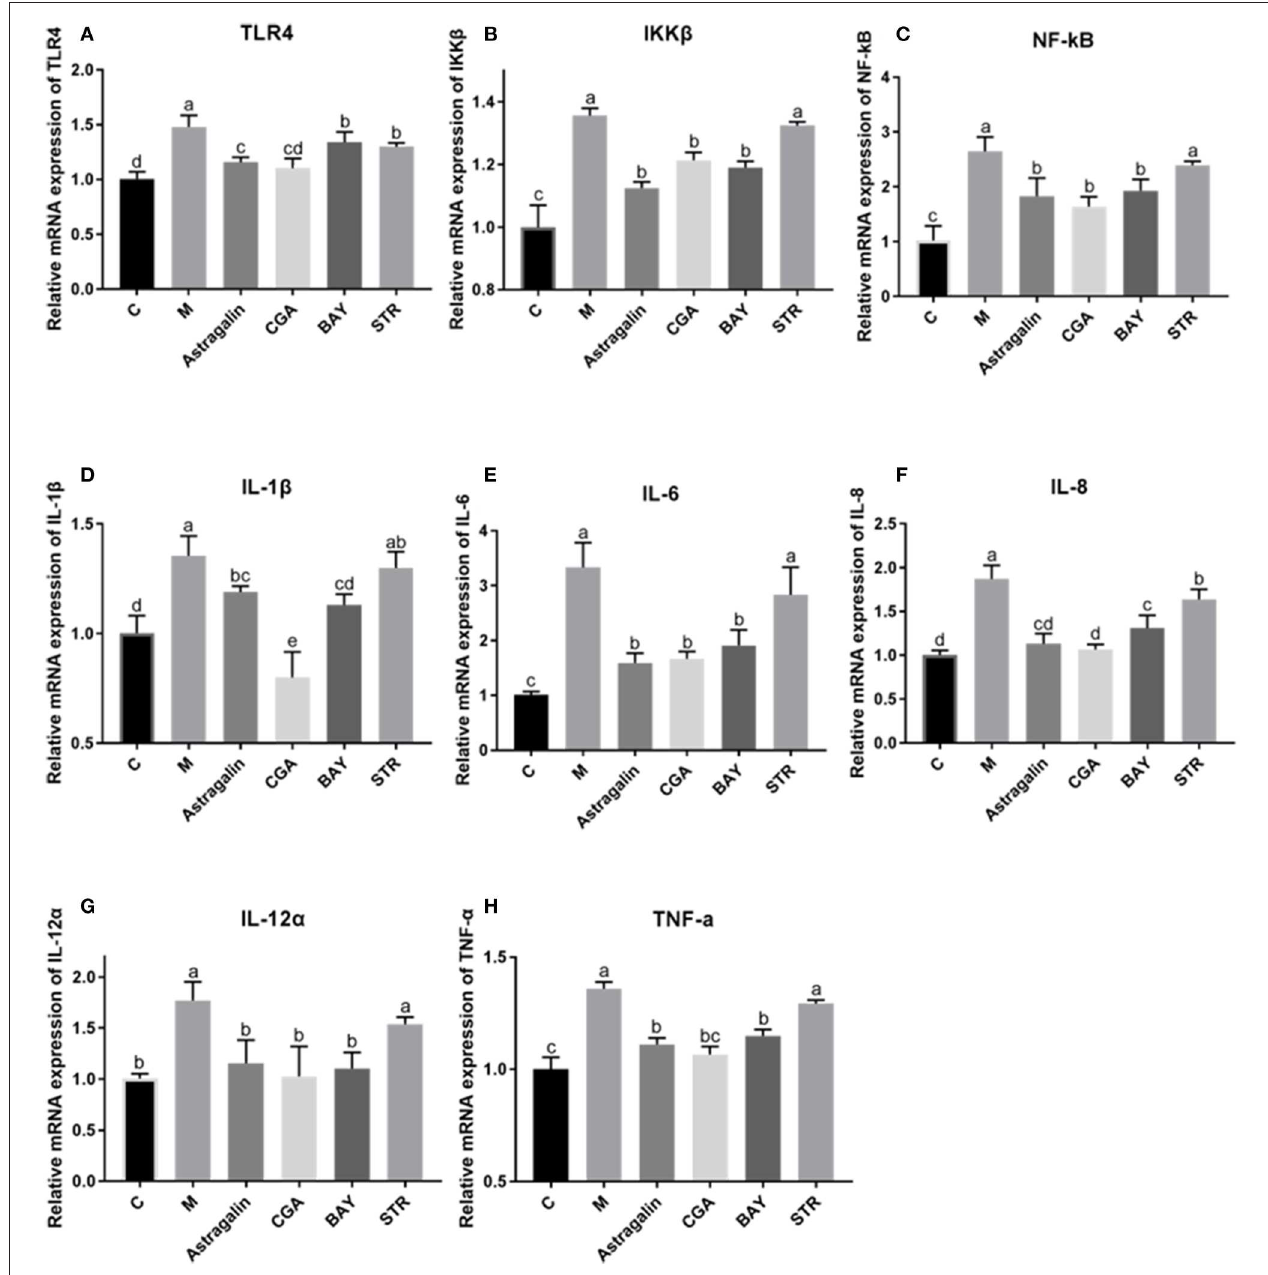
FIGURE 8 | The relative mRNA expression of genes in the TLR4/NF- κ B pathway. The SEECs were pretreated for 3h with various compounds (astragalin, CGA, BAY, and STR) and then exposed to E. coli for 3h, and the mRNA expressions of TLR4, IKK β , NF- κ B, IL-1 β , IL-6, IL-8, IL-12 α , and TNF- α were detected by qPCR. (A) The relative mRNA expression of TLR4. (B) The relative mRNA expression of IKK β . (C) The relative mRNA expression of NF- κ B. (D) The relative mRNA expression of IL-1 β . (E) The relative mRNA expression of IL-6. (F) The relative mRNA expression of IL-8. (G) The relative mRNA expression of IL-12 α . (H) The relative mRNA expression of TNF- α . Data are represented as the mean ± SD of three independent experiments with mixed SEECs from 15 sheep. Values with different lowercase letters were considered as statistically significant ( P <